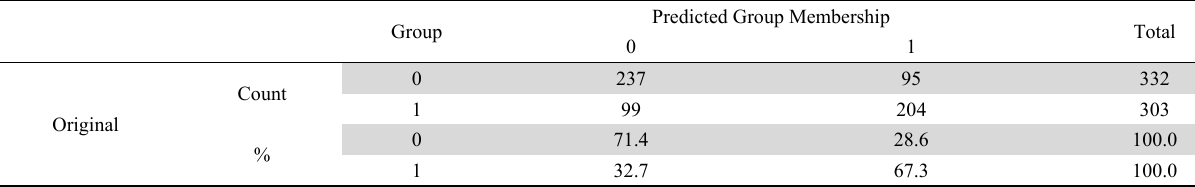
Predicted Group